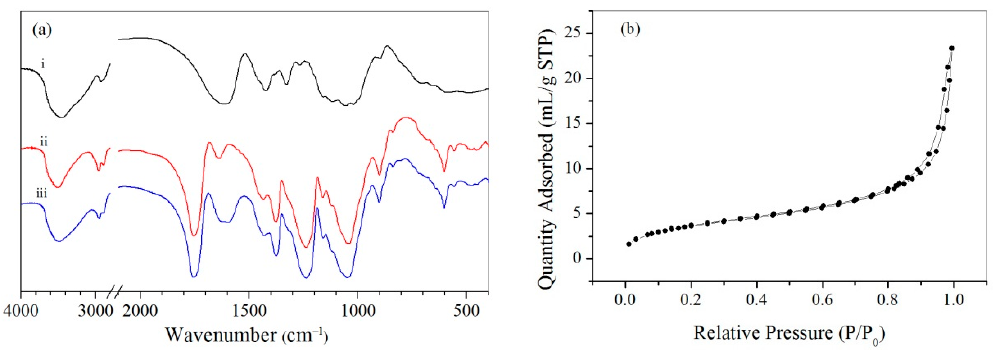
Figure 3. ( a ) FTIR of CMC (i), CA (ii), and CMC/CA microspheres (iii). ( b ) Typical nitrogen adsorption curves of CMC/CA microspheres.